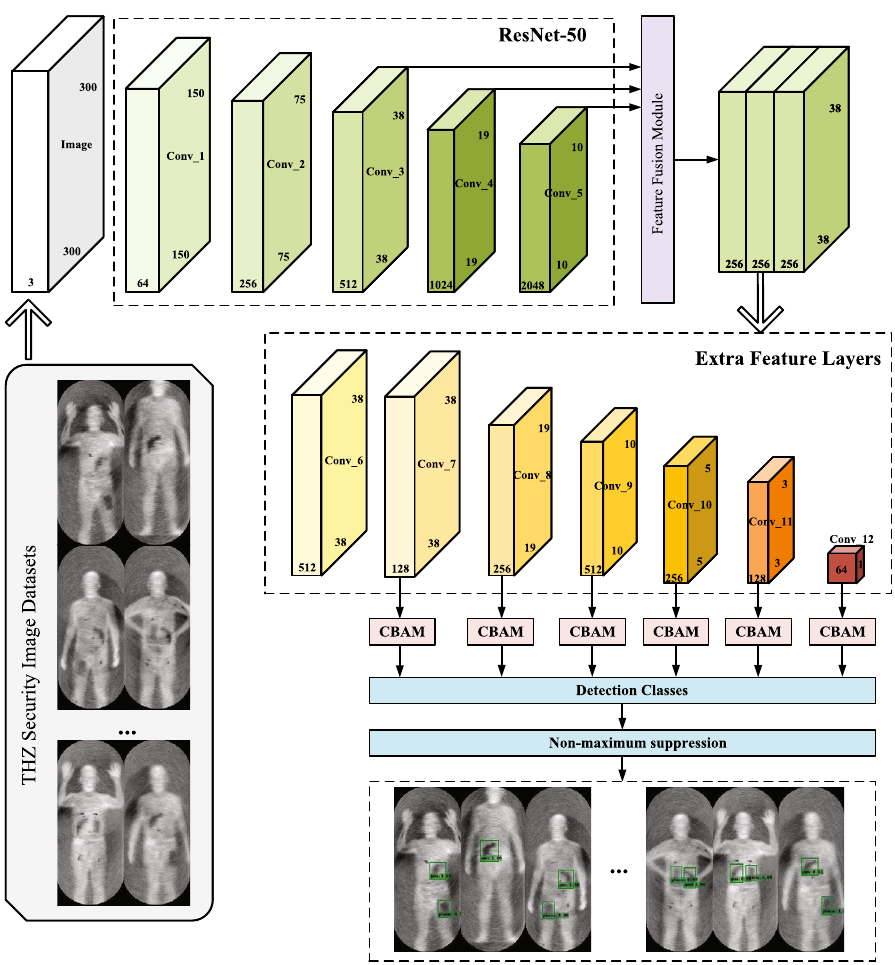
Figure 2. Improved SSD network